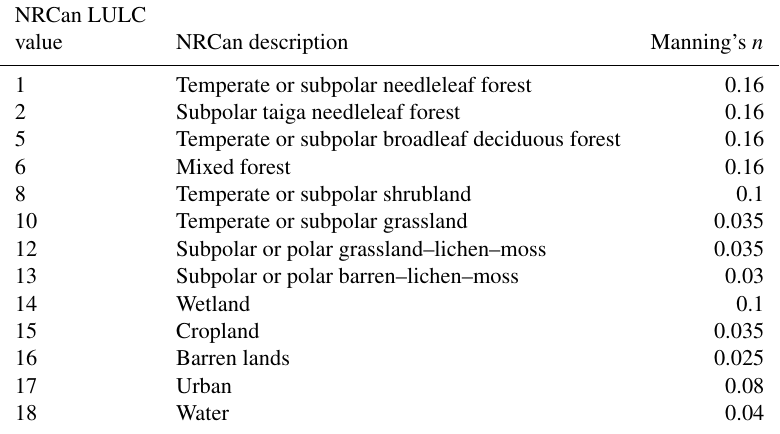
Table 1. Values of Manning’s n